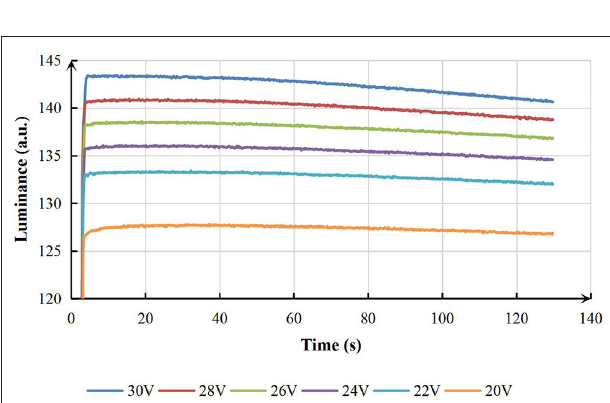
FIGURE 8 | The relationship between brightness and driving time when an EWD panel was driven by different DC